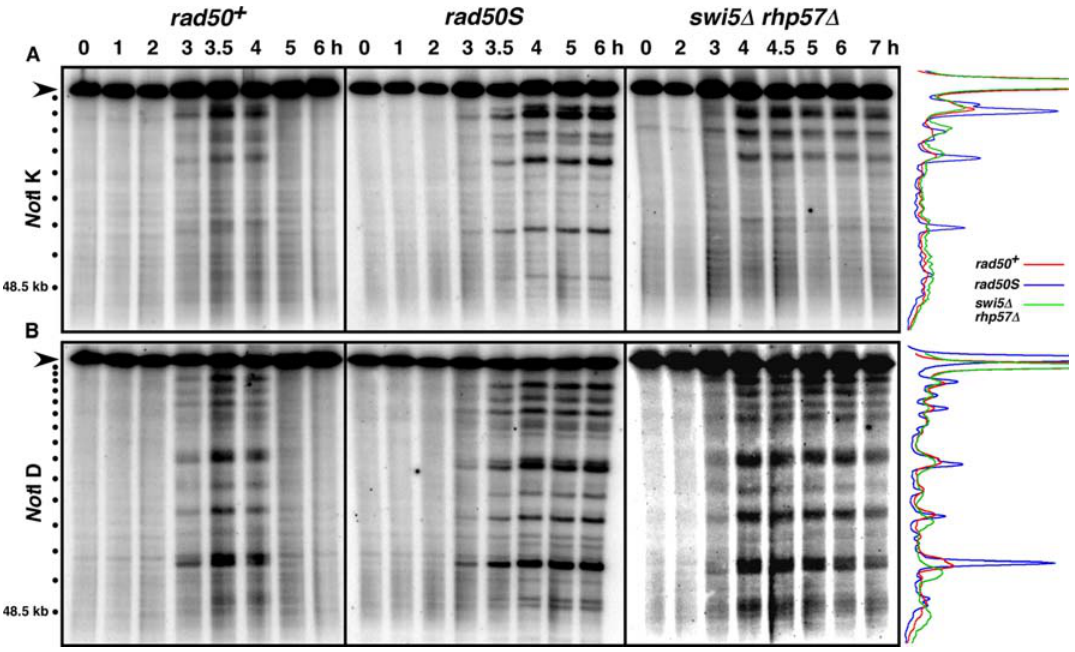
Figure 1. Southern Blots Reveal Indistinguishable DSB Hotspots in rad50 + and rad50S Strains. DNA from meiotically induced strains was digested with Not I, and the fragments separated by pulsed-field gel electrophoresis. Inductions were performed concurrently with rad50 + (GP1979; left), rad50S (GP3718; middle), and swi5 D rhp57 D (GP6658; right) strains. (A) The blots were probed on the left end of the 480 kb Not I restriction fragment K (black arrowhead) of chromosome I. (B) The same blots were probed on the left end of the 1.2 Mb Not I restriction fragment D (black arrowhead) of chromosome I. On the left are size markers, 48.5 kb phage lambda DNA (lowest bullet) and its concatemers. On the right are lane traces of the time of maximal DSBs [3.5 h rad50 + (blue) and 5 h rad50S (red), and 4.5 h swi5 D rhp57 D (green)] for each probing. Similar results were obtained in an independent induction of the rad50 + strain (Figure S2). doi:10.1371/journal.pgen.1000267.g001 [20]. Our results show that a significant fraction of the DNA at DSB hotspots in S. pombe rad50 + strains remains linked to a protein, likely Rec12.